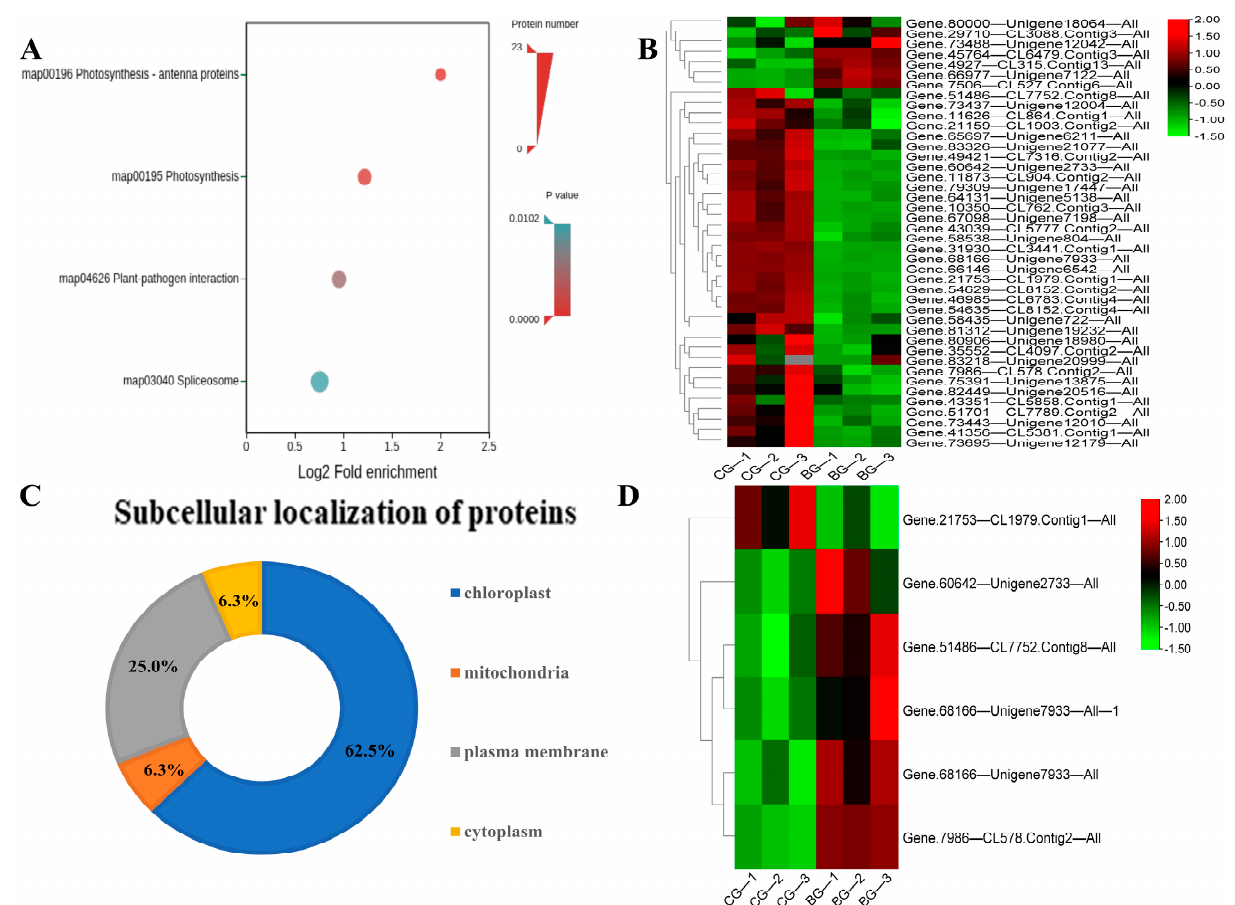
Figure 5. KEGG enrichment analysis, clustering analysis, and subcellular location prediction of the UV-B-responsive proteins. ( A ) KEGG enrichment analysis of differential proteins under UV-B stress; ( B ) heatmap of the photosynthetic proteins; ( C ) subcellular localization of the photosynthetic proteins; ( D ) heatmap of the photosynthetic acetylated proteins.